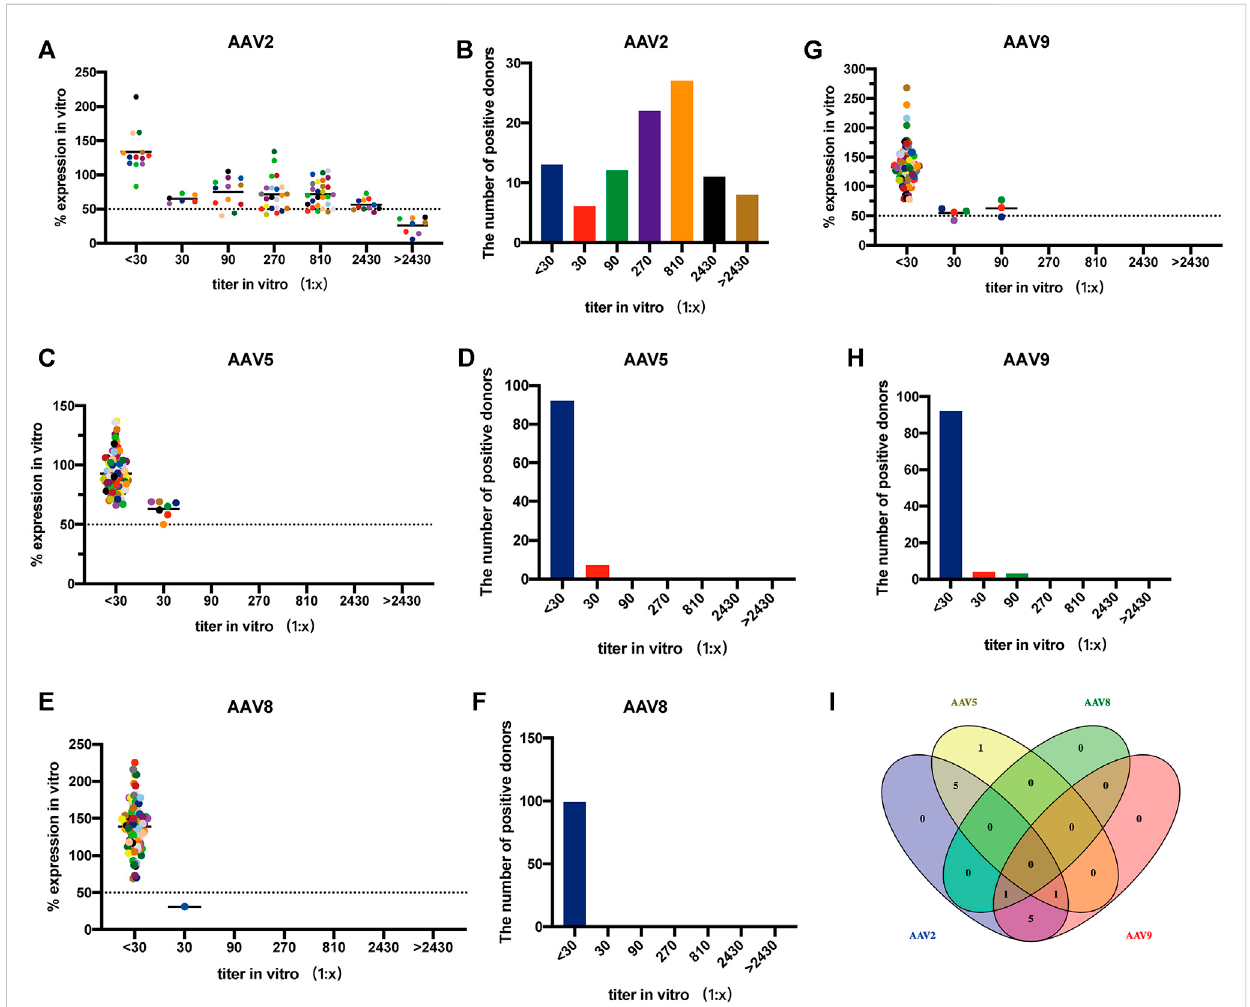
FIGURE 6 Seroprevalence of NAbs to AAVin adults using AAVR-HeLacells. The serum samples of 99 Chinese adults wereused for the NAb survey.The AAVR- HeLa cells were seeded onto 96-well plates and serial dilutions of serum samples were mixed with rAAV-Luc along with different serotypes. The AAVR- HeLacellsweretheninfectedwiththerAAV-serummixandRLUweremeasuredbythe fl uorescencemicroplatereader.TheRLUvalueobtainedfromthe negative control, namely DMEM only, was de fi ned as 100%. RLU inhibition was de fi ned as the percentage of RLU obtained to that from the negative control.ND 50 valueswerecalculatedasthedilutionswhichinhibitedthetransductionby50%.TheND 50 ofNAbtitersagainstAAV2 (A) ,AAV5 (C) ,AAV8 (E) and AAV9 (G) were evaluated, and the corresponding bar charts were also presented (B, D, F, H) . (I) Venn diagram analysis of the NAb cross-reactivity to different AAV